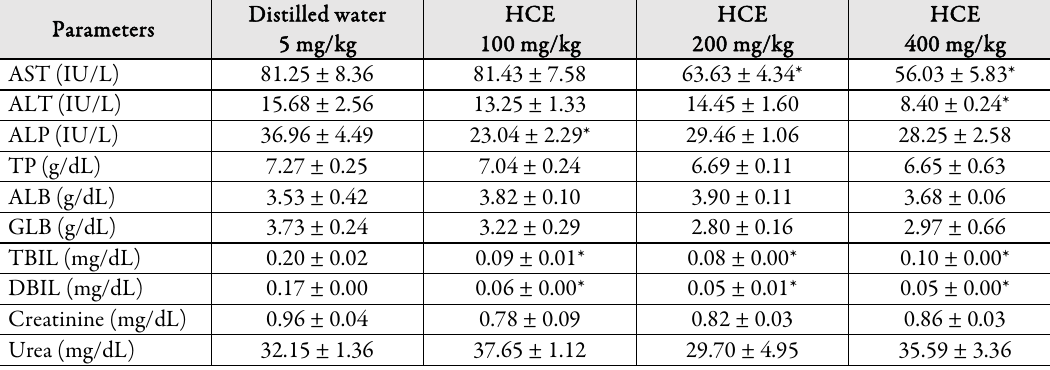
Table 4. Effects of HCE on serum biochemical parameters of treated rats Distilled water HCE HCE HCE Parameters 5 mg/kg 100 mg/kg 200 mg/kg 400 mg/kg AST (IU/L) 81.25 ± 8.36 81.43 ± 7.58 63.63 ± 4.34* 56.03 ± 5.83* 15.68 ± 2.56 13.25 ± 1.33 14.45 ± 1.60 36.96 ±